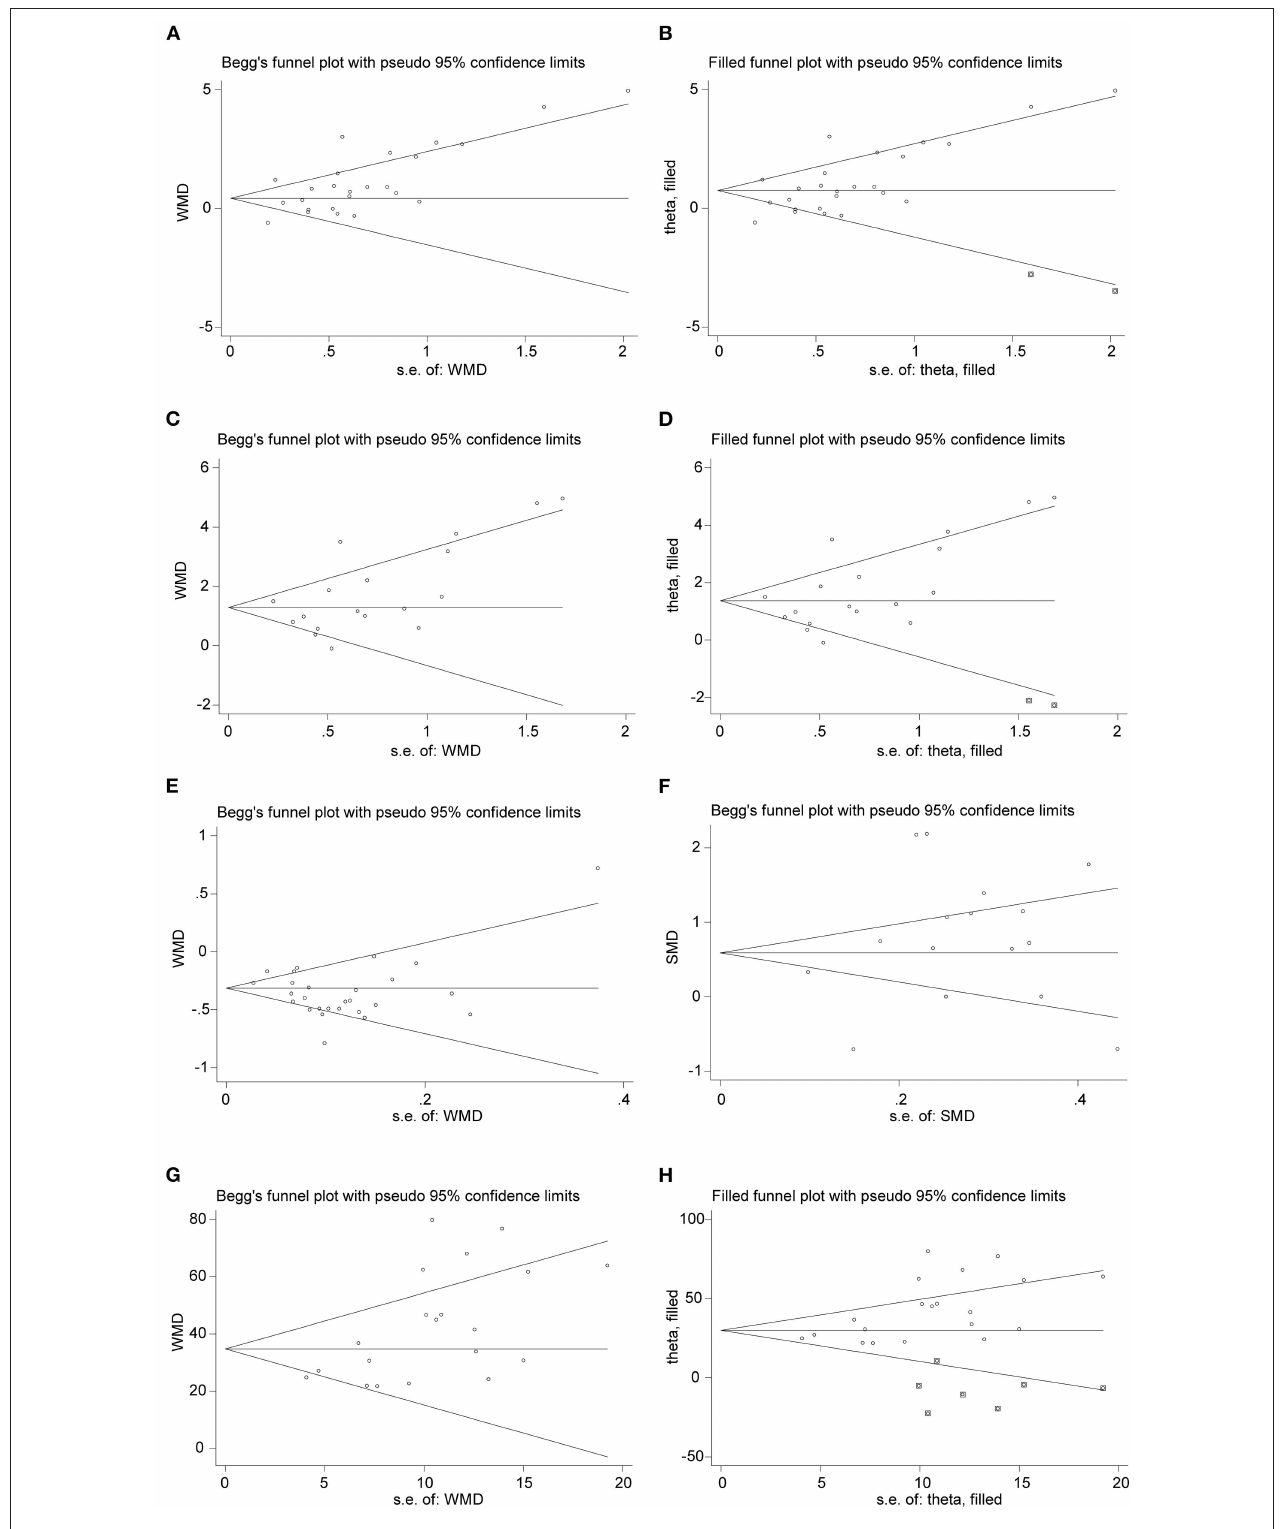
FIGURE 7 | Funnel plots of comparison of the included studies. (A,B) Funnel plot and adjusted funnel plot of mean difference in WBC count. (C,D) Funnel plot and adjusted funnel plot of mean difference in neutrophil count. (E) Funnel plot of mean difference in lymphocyte count. (F) Funnel plot of Std. mean difference in PCT. (G,H) Funnel plot and adjusted funnel plot of mean difference in